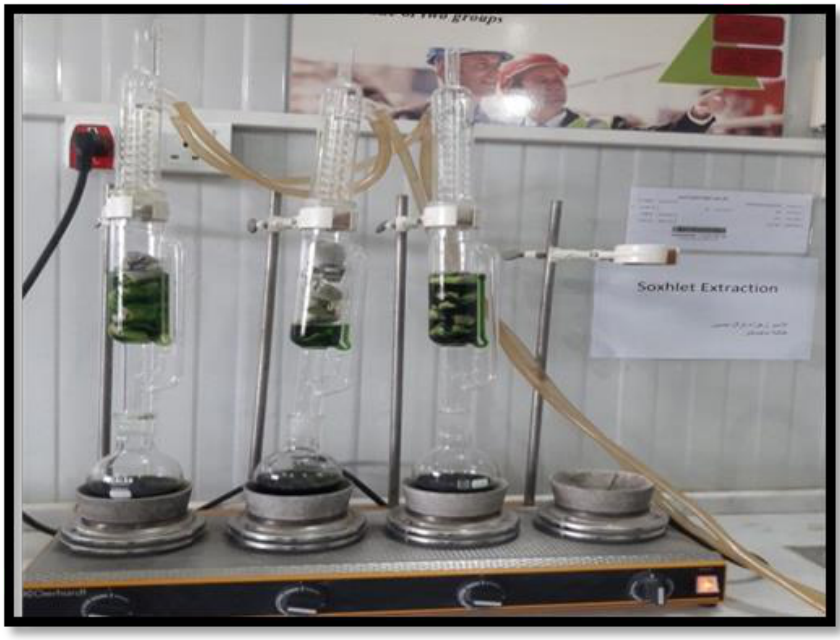
Fig. 1. Photographic pictures of Soxhlet extraction.